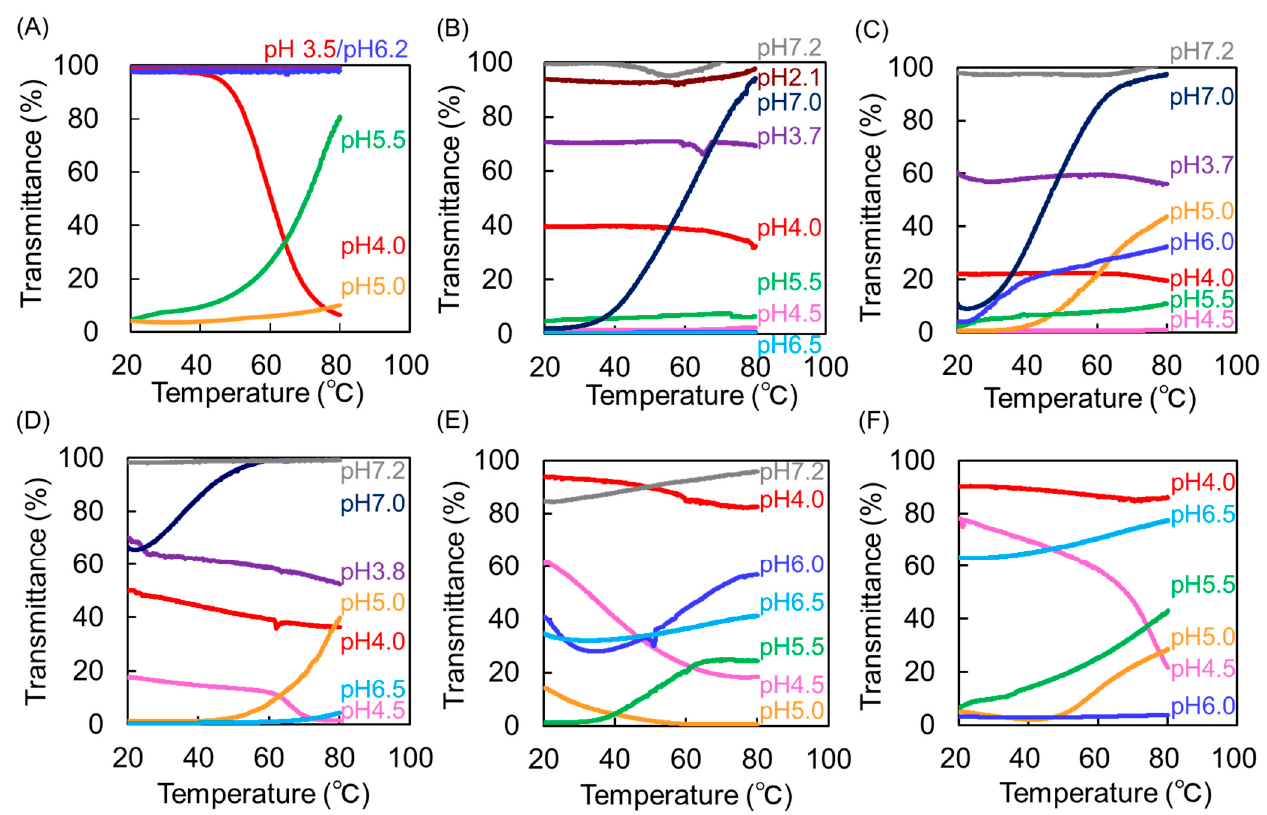
Figure 3. Temperature-dependent transmittance curves of aqueous solutions containing carboxylate-terminal Phe-modified dendrimer with different Phe/PAMAM ratios and different terminal groups at different pH values (1 mg/mL). ( A ) PAMAM-Phe56-Suc was referred to our previous paper [27]. ( B ) PAMAM-Phe-64-CHex, ( C ) PAMAM-Phe46-CHex, ( D ) PAMAM-Phe35-CHex, ( E ) PAMAM-Phe27-CHex, and ( F ) PAMAM-Phe16-CHex.